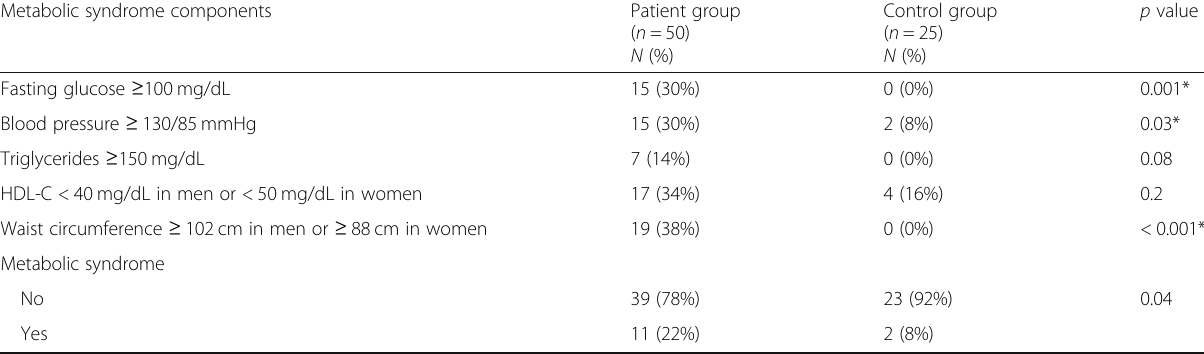
HDL-C High-density lipoprotein cholesterol * p value <0.05 is considered statistically